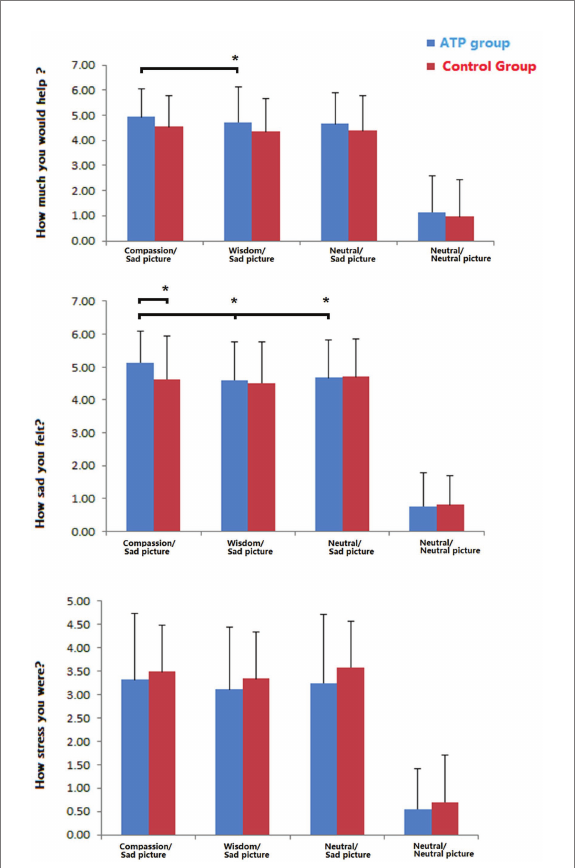
FIGURE 7 Behavioural measurements and comparison of how the participants felt when viewing the negative pictures. Note that all the scores are significantly different between negative and neutral pictures ( p < 0.001). ATP, Awareness Training Program. significant difference (* p <